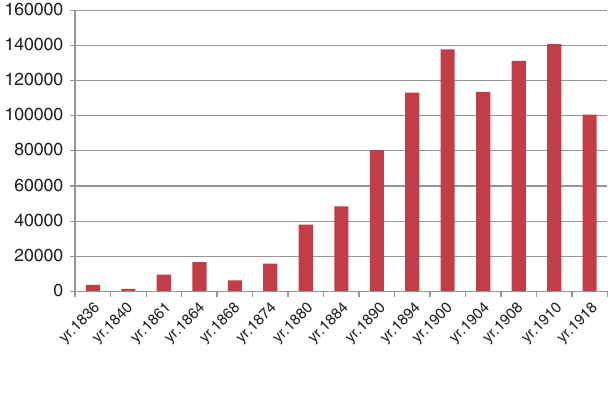
Fig. 2: Number of characters in journal GT data for each